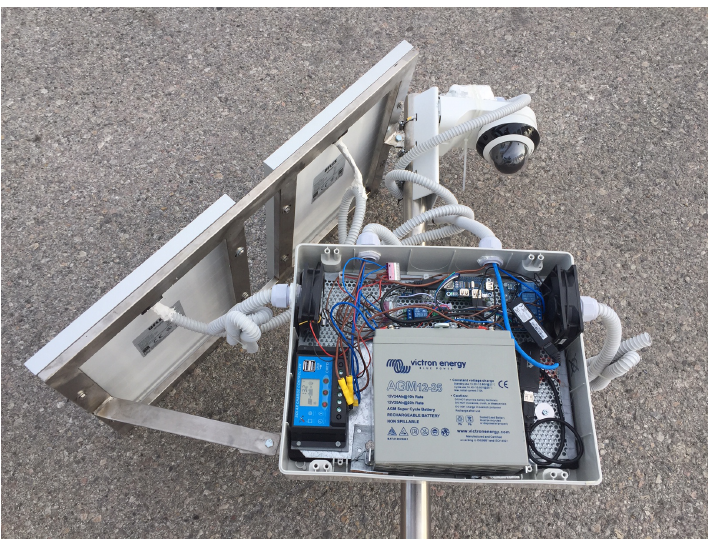
Figure 11. Prototype of